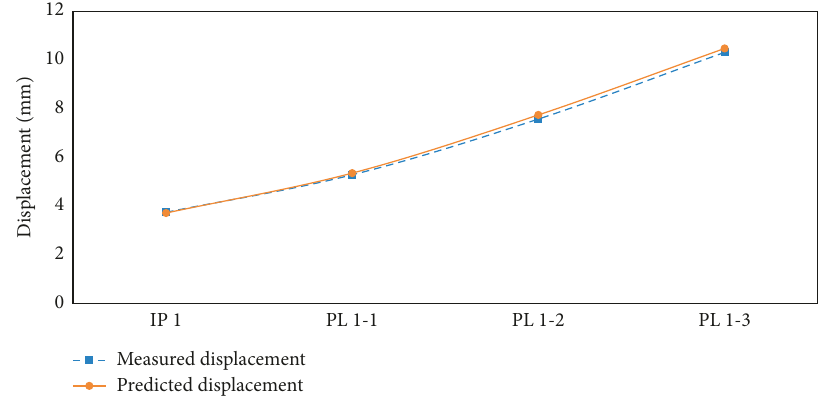
Figure 10: Comparison between the measured displacement and the predicted